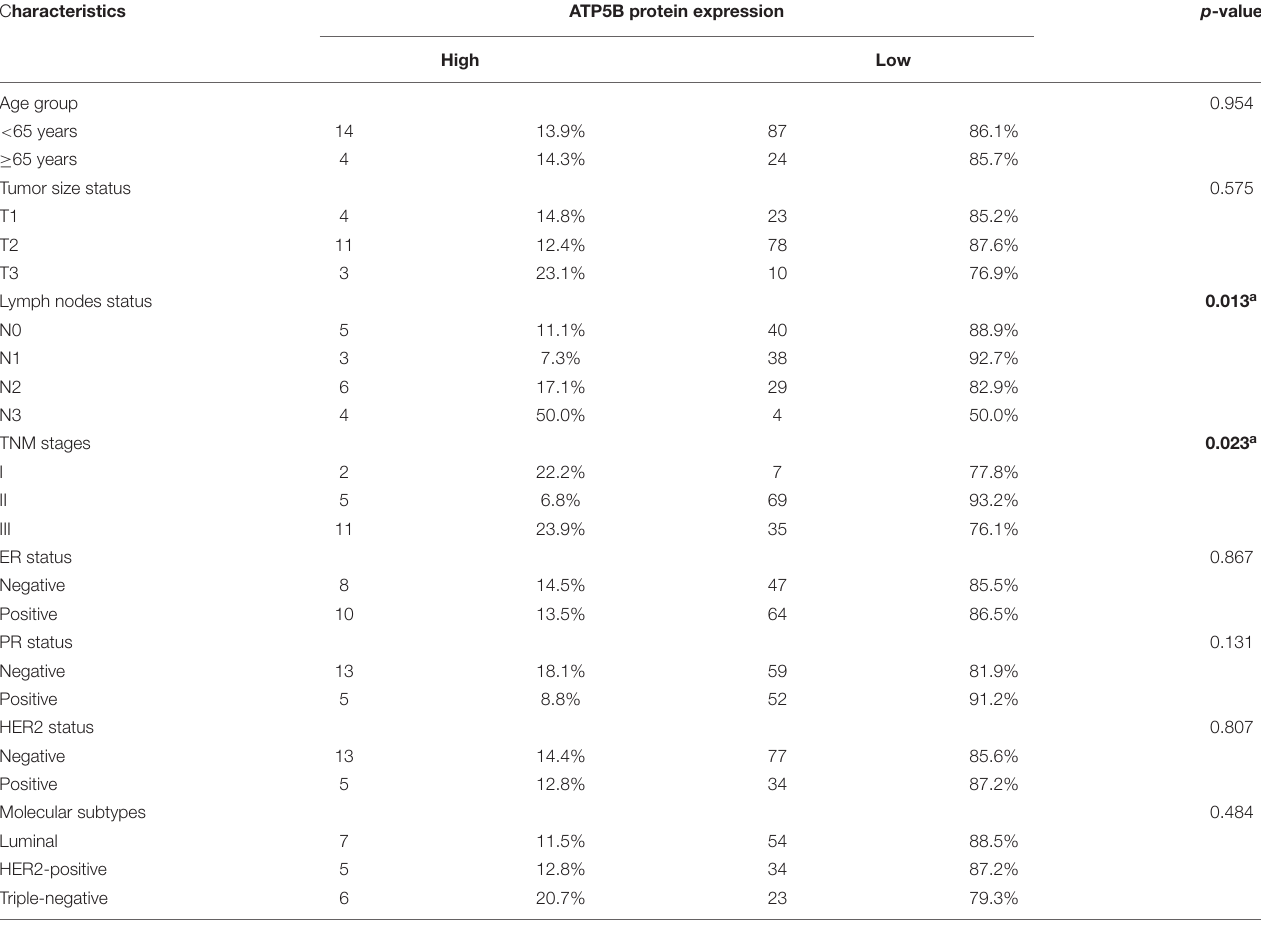
TABLE 1 | Association between ATP5B protein expression and the clinicopathological characteristics of breast cancer patients. C haracteristics